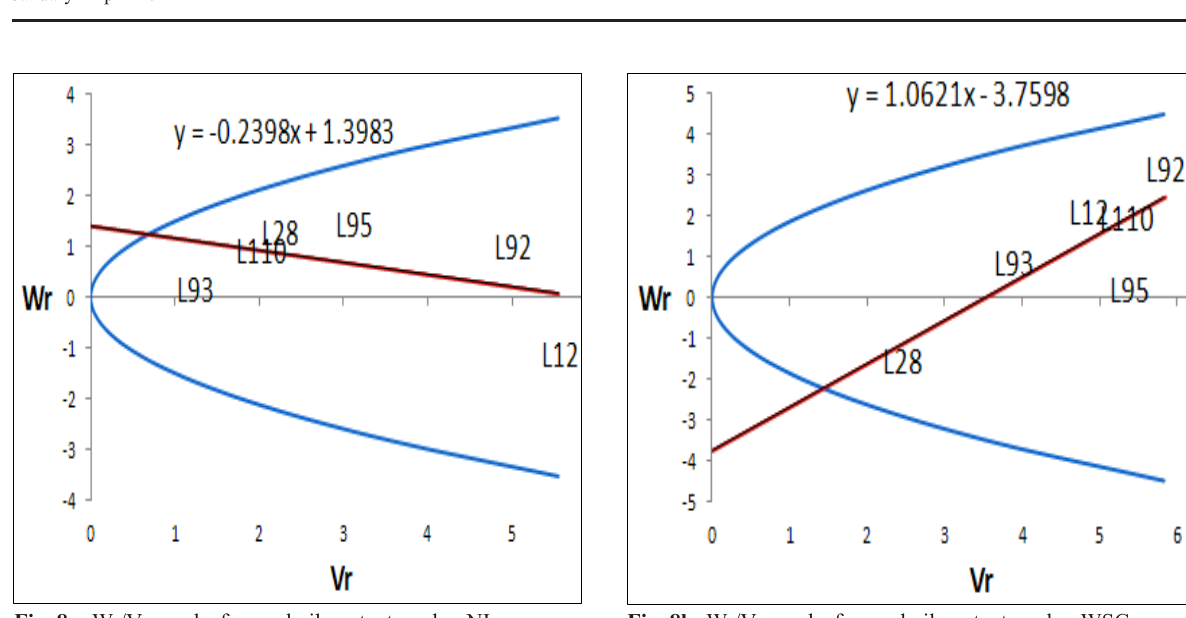
Fig. 8a: Wr/Vr graphs for seed oil content under NI Fig. 8b: Wr/Vr graphs for seed oil content under